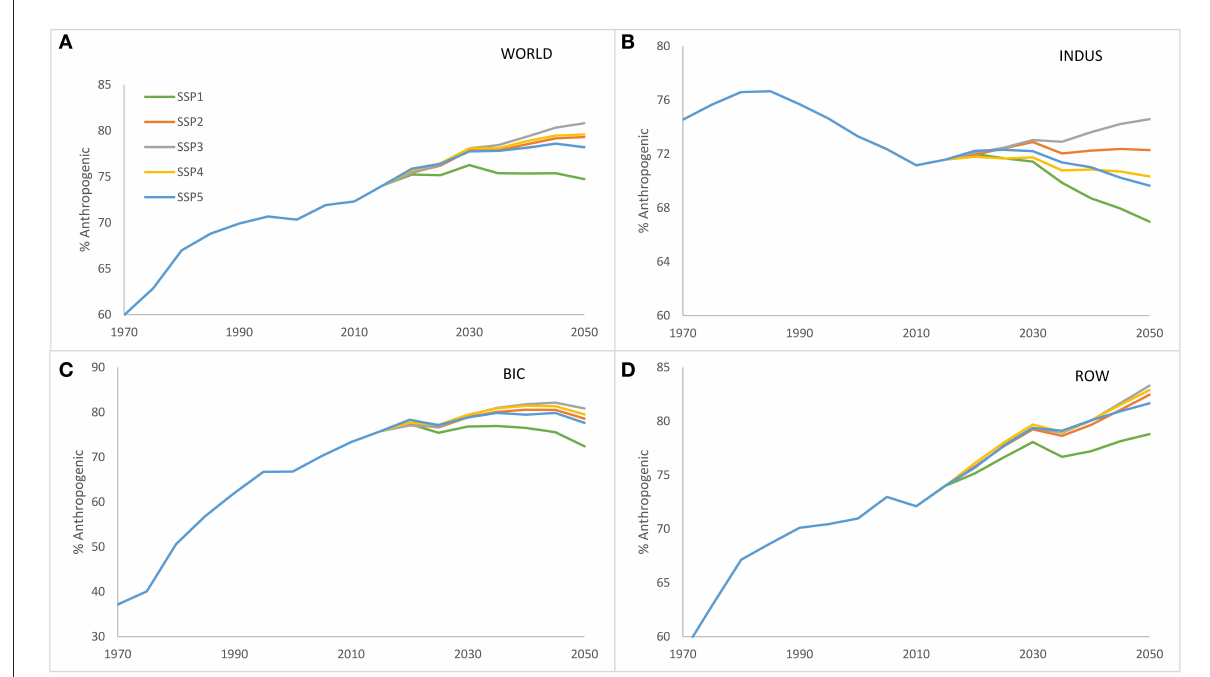
FIGURE3 Percentage of N delivery which is from anthropogenic sources for (A) the world, (B) INDUS, (C) BIC, and (D) ROW for the five SSPs.